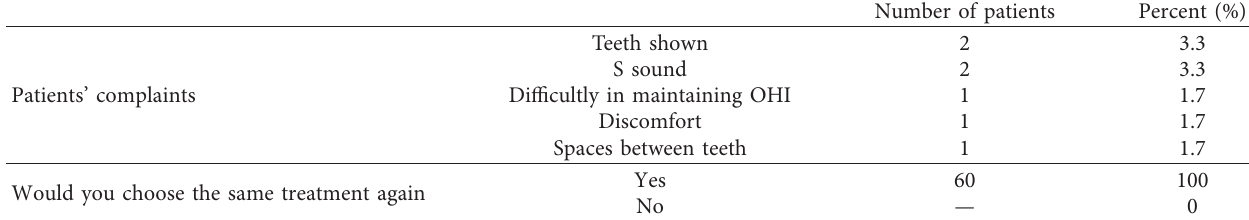
Table 6: Participants’ complaints after basal implant treatment and probability of choosing the same treatment again.